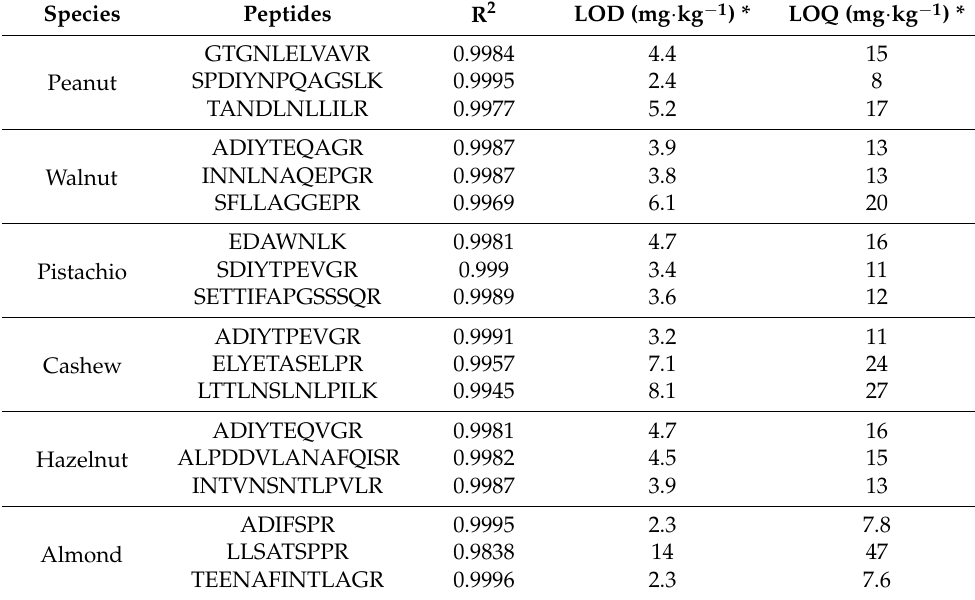
Table 4. Correlation coefficients and detection (LOD) and quantification limits (LOQ) values ob- tained after calibrations performed for the six allergenic ingredients of interest in the cookie matrix considering specific marker